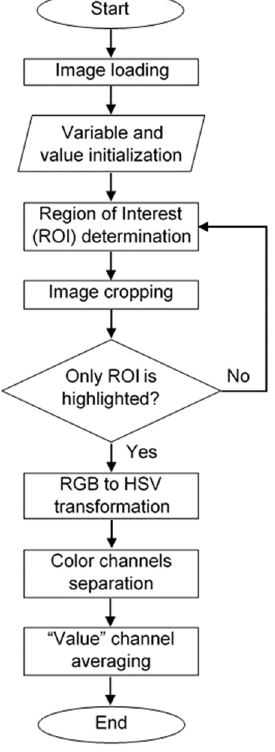
Figure 3. The image processing algorithm.